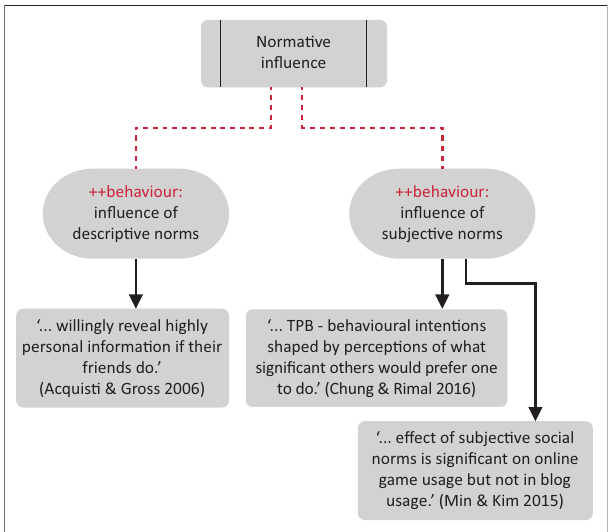
FIGURE 2: Partial thematic map used to argue the behavioural influence of subjective norms.